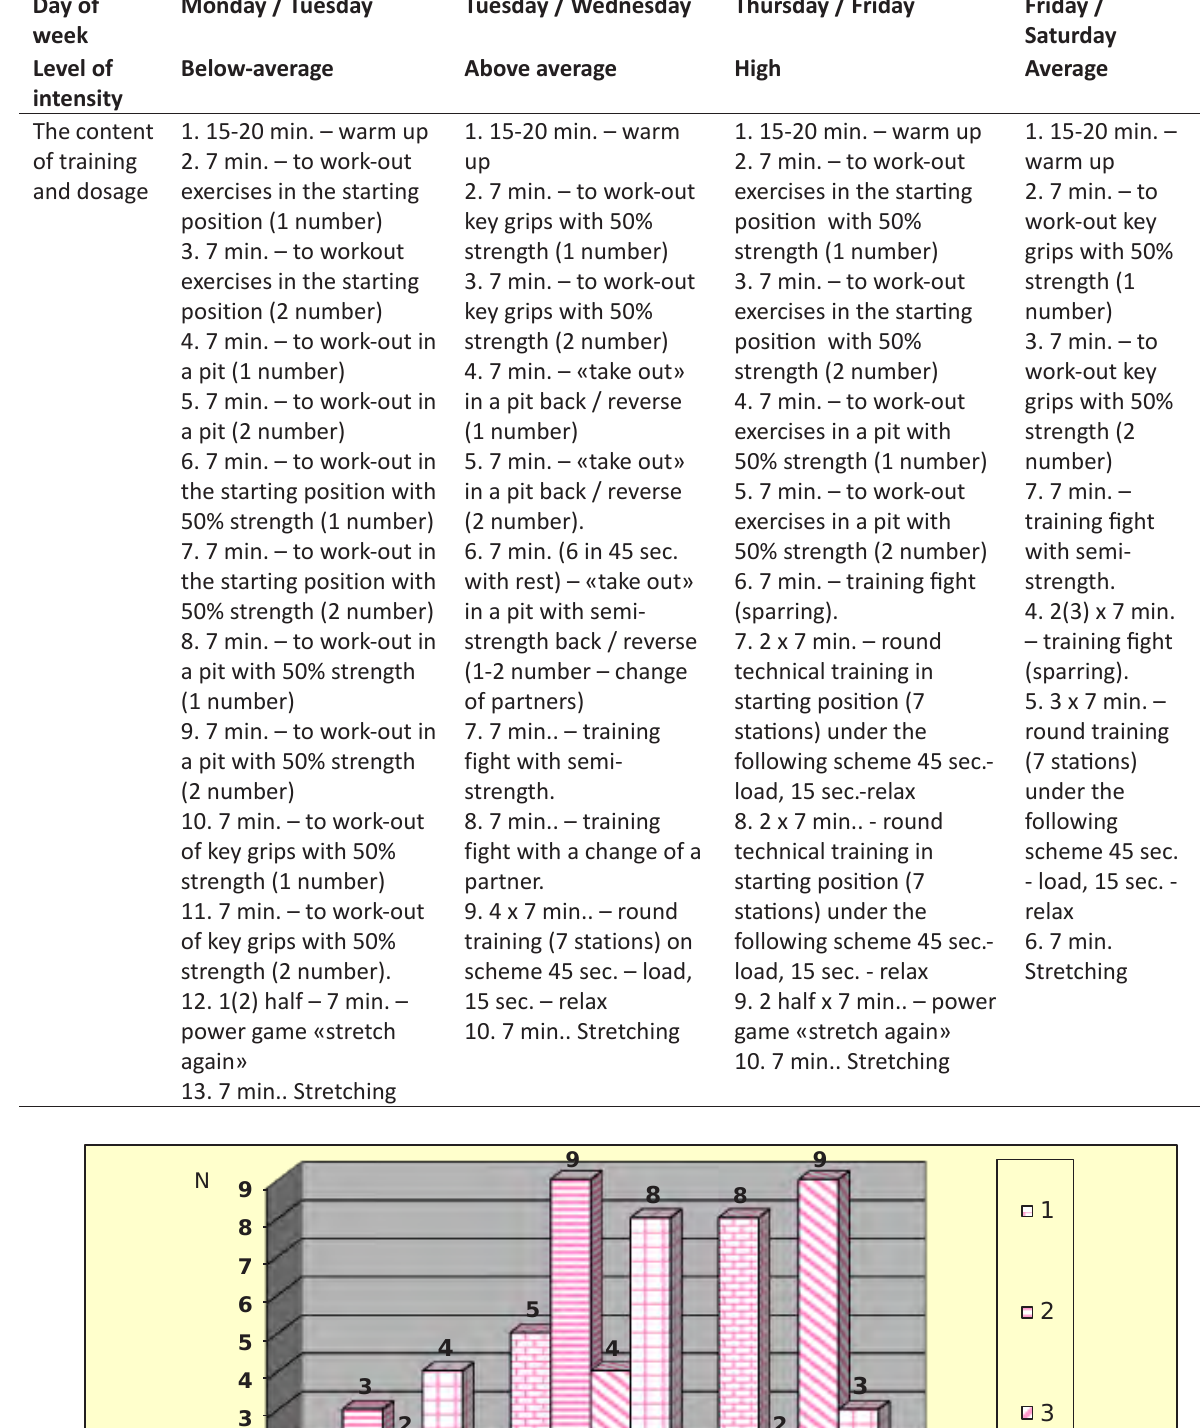
Table 1. The plan of the weekly training cycle of Greco-Roman wrestlers in the aspect of special loading dosing Day of